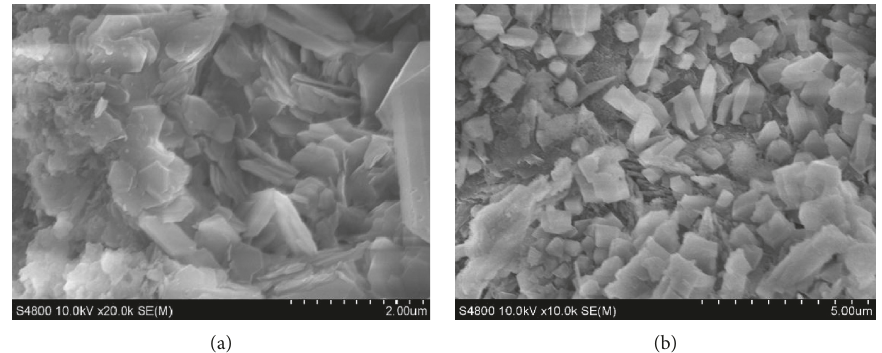
Figure 9: SEM of mortars with different grinding times at 28d age. (a) SJ1; (b) SJ5; Ca(OH)